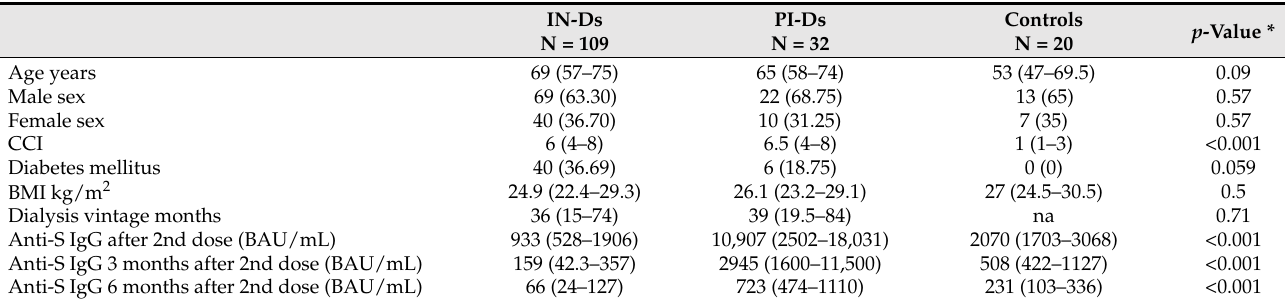
Table 1. Patient characteristics (protocol